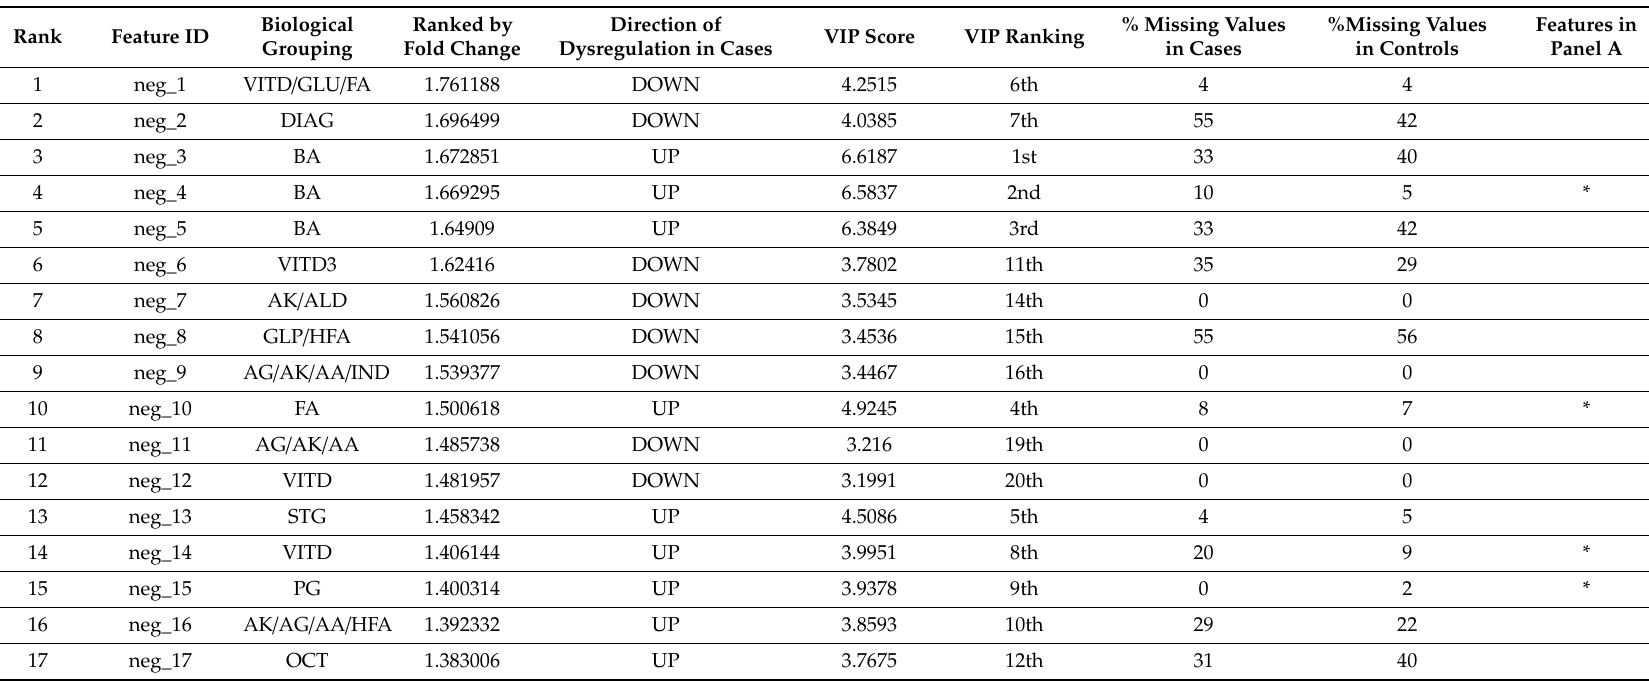
Table 2. Ranked results of univariate and multivariate analysis on 20 weeks GA